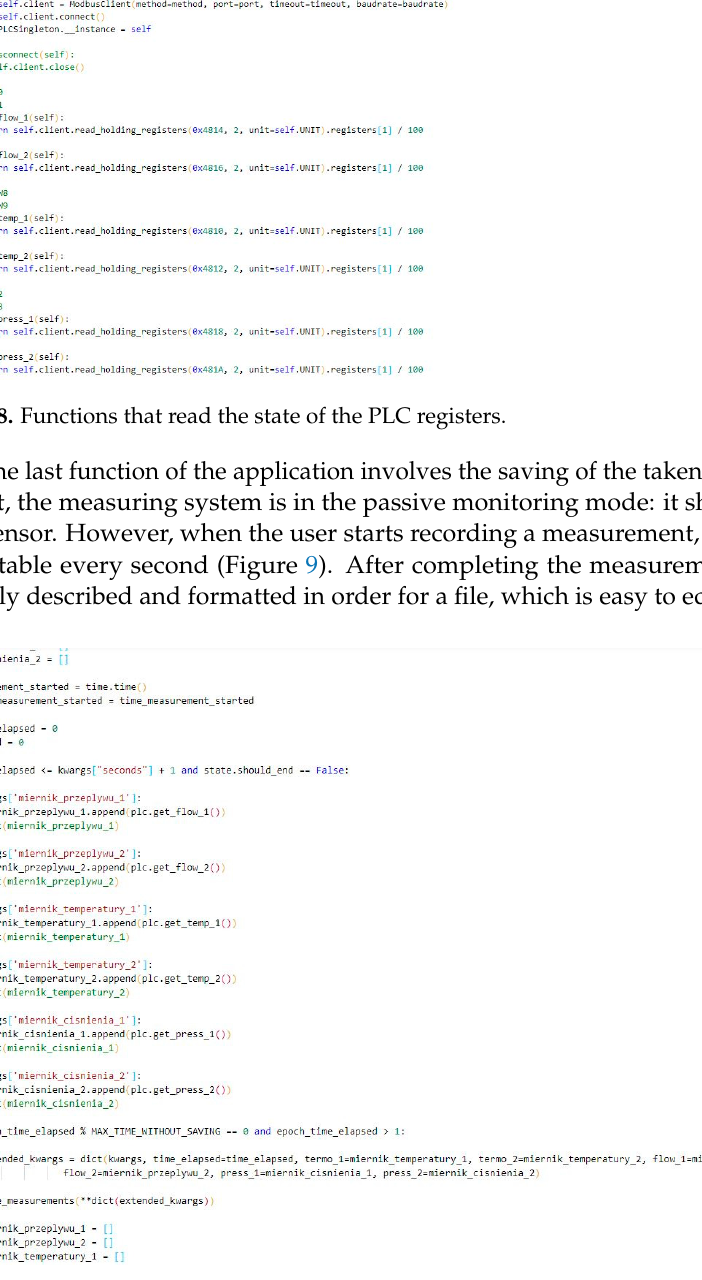
Figure 9. Fragment of the code that is responsible for recording the measurements.